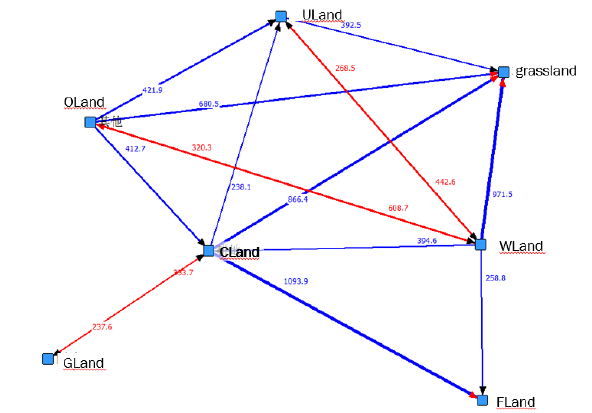
Table 2. Source - Direction matrix of LCA and DLTB of Dongying City (Area Unit: km 2 )